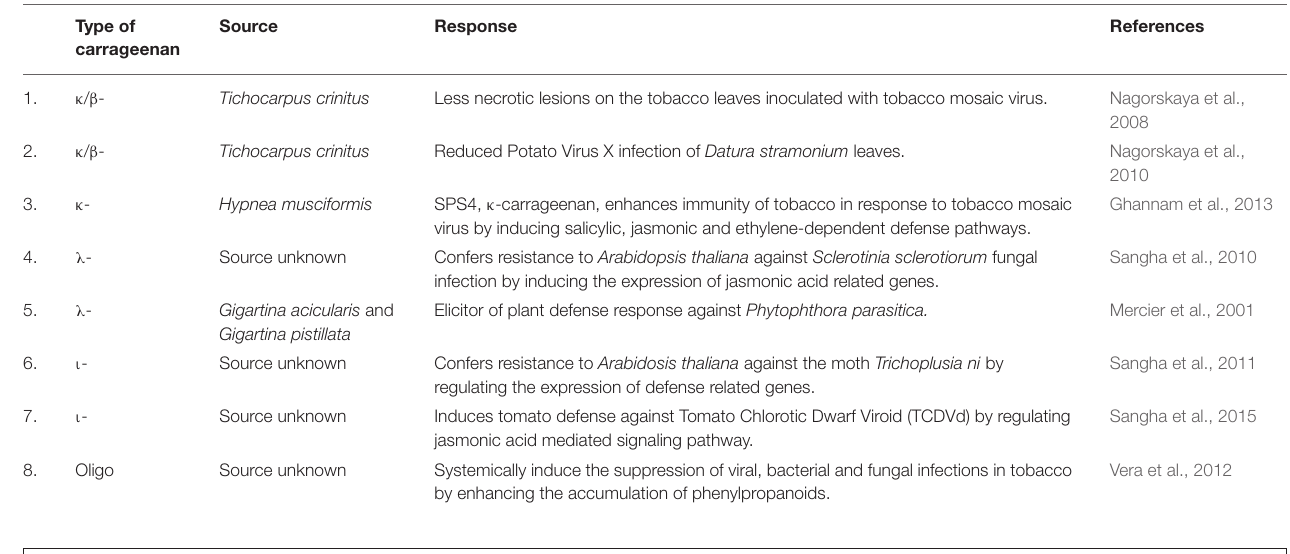
TABLE 2 | Role of carrageenans in plant defense.